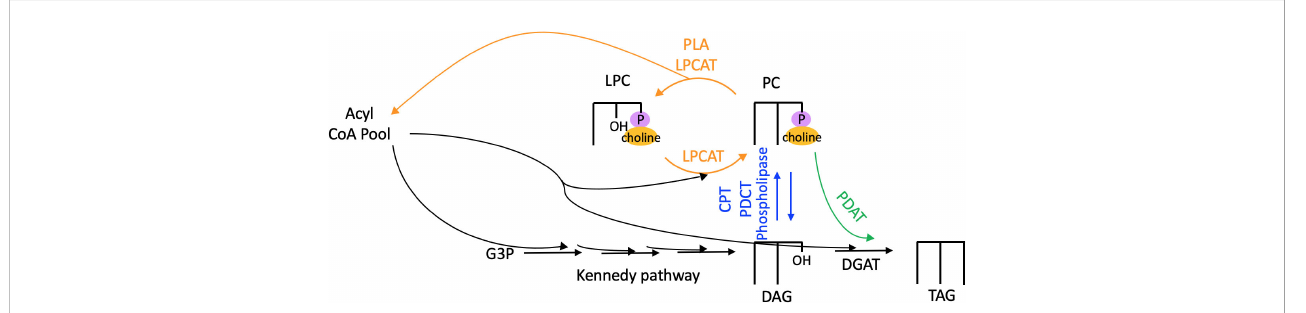
FIGURE 4 Routes of acyl fl ux through PC into TAG. Orange arrows, PC acyl editing reactions. Blue arrows, headgroup exchange for PC-DAG conversion. Green arrows, transfer of an acyl group from PC onto TAG via the acyltransferase PDAT. CPT, cytidine-5 ′ -diphosphocholine:diacylglycerol cholinephosphotransferase; DAG, diacylglycerol; DGAT, diacylglycerol acyltransferase; G3P, glycerol 3-phosphate; LPC, lyso-phosphatidylcholine; LPCAT, acyl-CoA:lysophosphatidylcholine acyltransferase; PC, phosphatidylcholine; PDAT, phospholipid:diacylglycerol acyltransferase; PDCT, phosphatidylcholine:diacylglycerol cholinephosphotransferase; PLA, phospholipase; TAG,